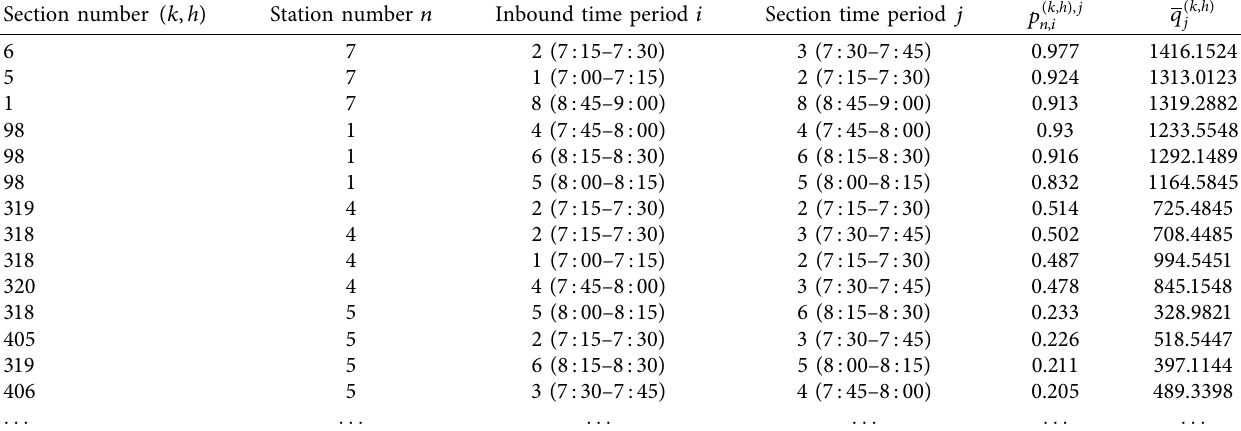
Table 4: Fitting coefficients of stations and sections during morning peak hours (part).